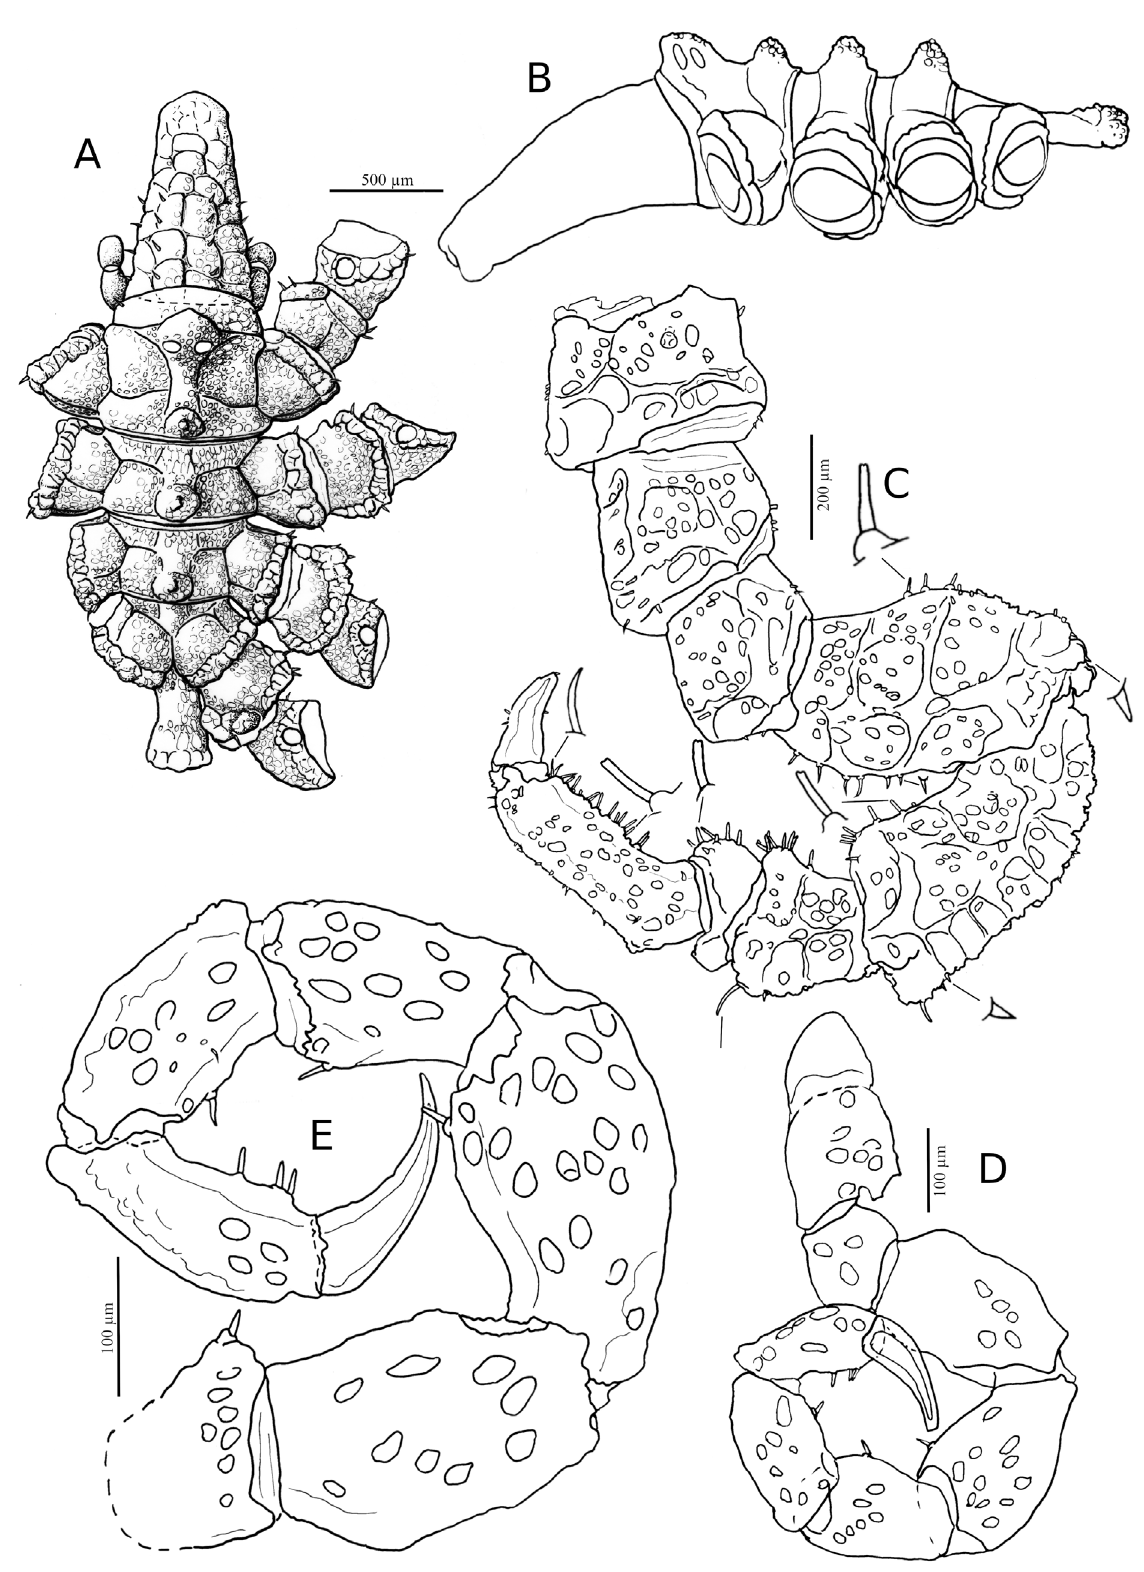
Fig. 28. Pycnogonum cesairei sp. nov., holotype, ♂, MNHN-IU-2016-10338. A . Body, dorsal view. B . Body, lateral view (same scale as A). C . Third leg. D . Oviger. E . Close-up of six terminal segments of